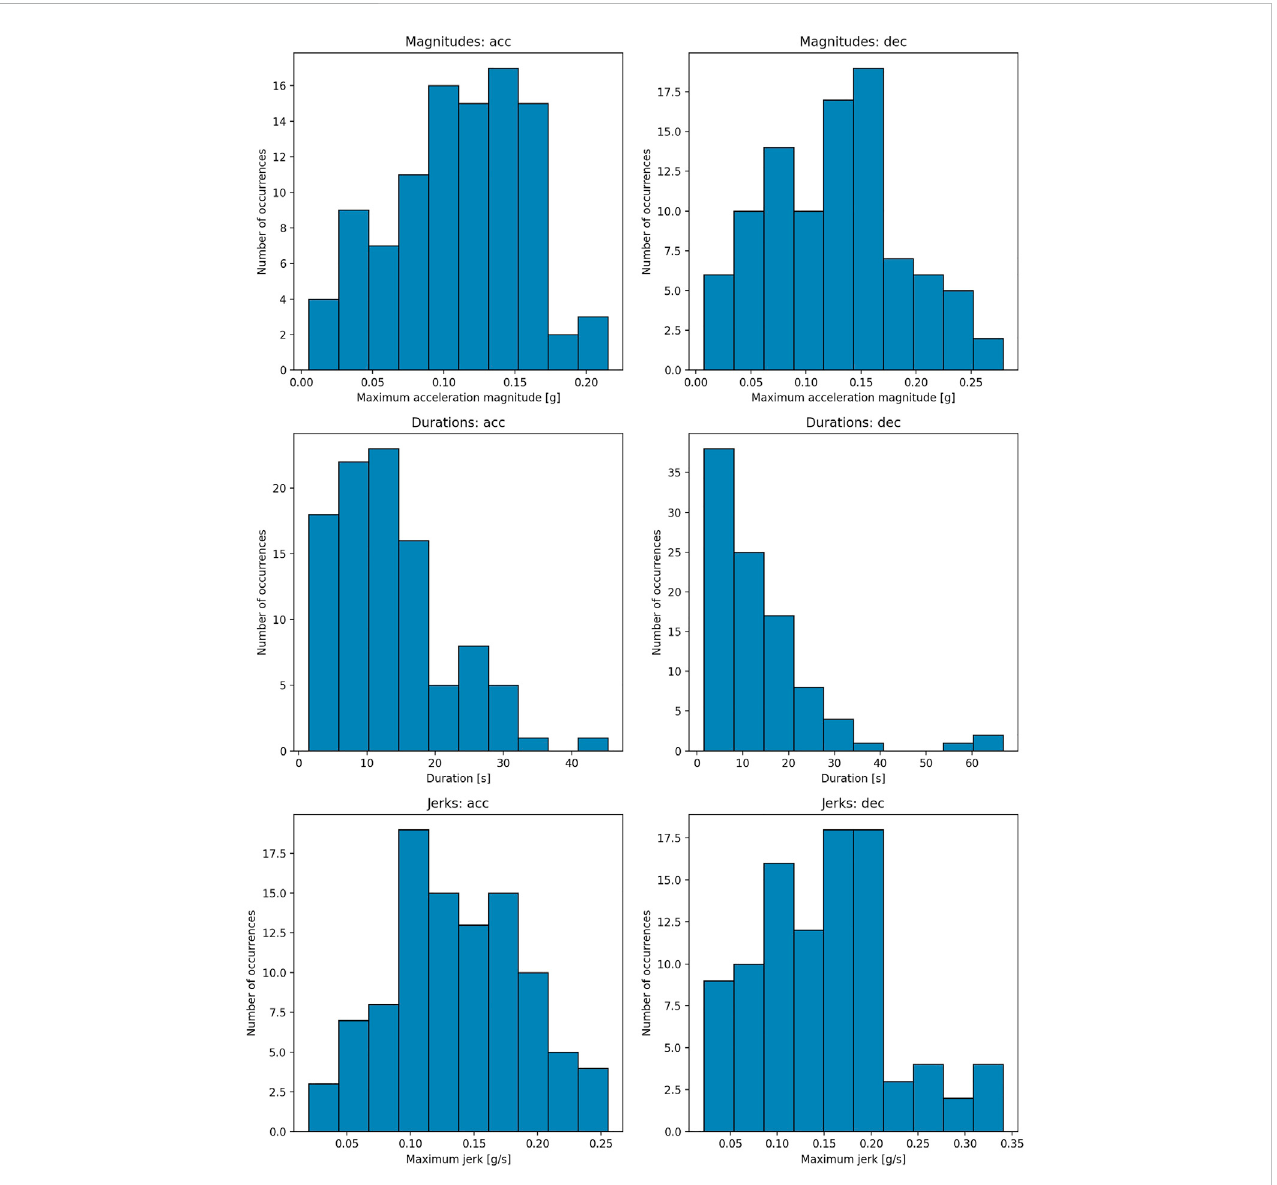
FIGURE 2 Histograms of acceleration magnitudes, peak jerk values and pulse duration for all vehicle